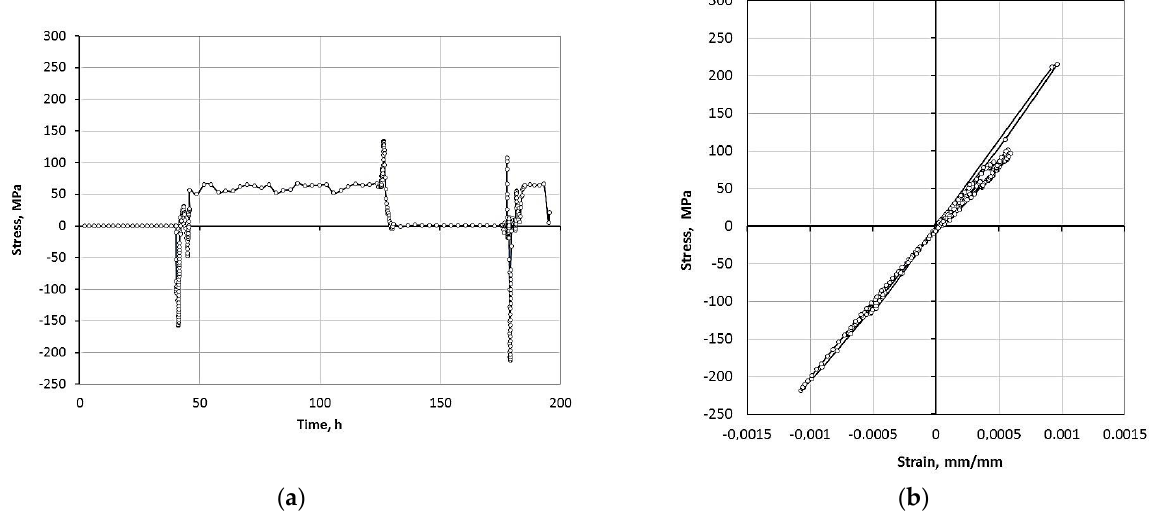
Figure 16. Temporal changes of the normal “z” component of the stress tensor ( a ) and the corresponding relationships between the normal “z” component of the total strain and stress tensors ( b ) (calculated for point A—Figure 14b, obtained on the basis of calculations of the case of 1000 W/m 2 K.